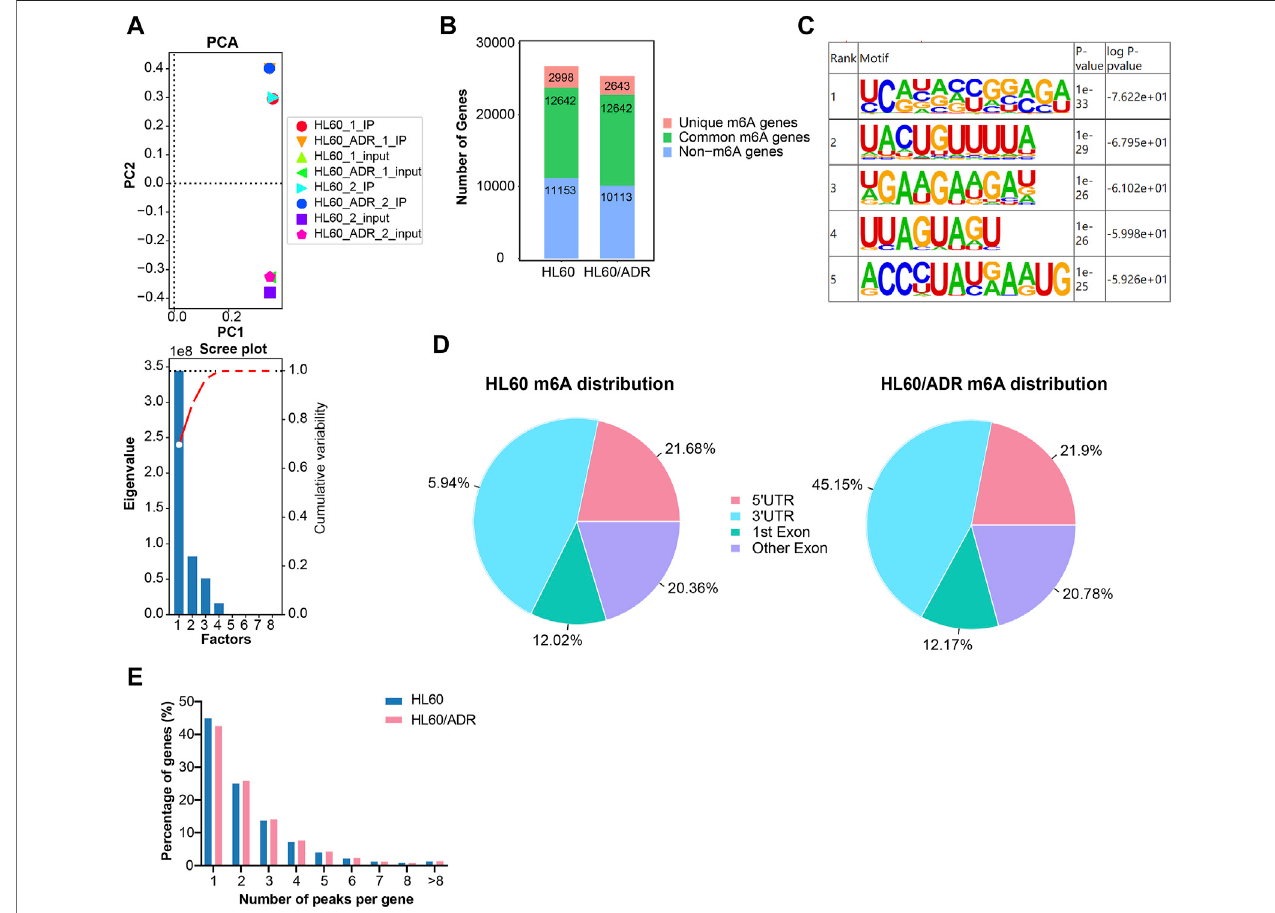
FIGURE1| Overviewofm 6 Amodi fi cationpatternsinHL60andHL60/ADRcells. (A) PCAanalysisrevealedthatbiologicallyduplicatedsamplesofHL60andHL60/ ADR were comparable. PCA, principal component analysis. (B) Distribution of m 6 A-modi fi ed genes and non-m 6 A-modi fi ed genes in HL60 and HL60/ADR. (C) Top fi ve conserved motifs identi fi ed from m 6 A peaks shared RRACH consensus sequences in both HL60 and HL60/ADR. (D) Enrichment of m 6 A peaks in different regions of transcripts, and m 6 A peaks were mostly enriched in 3 ′ UTR and CDS. UTR: untranslated region, CDS: coding sequence. (E) Percentage of genes harboring a different number of m 6 A